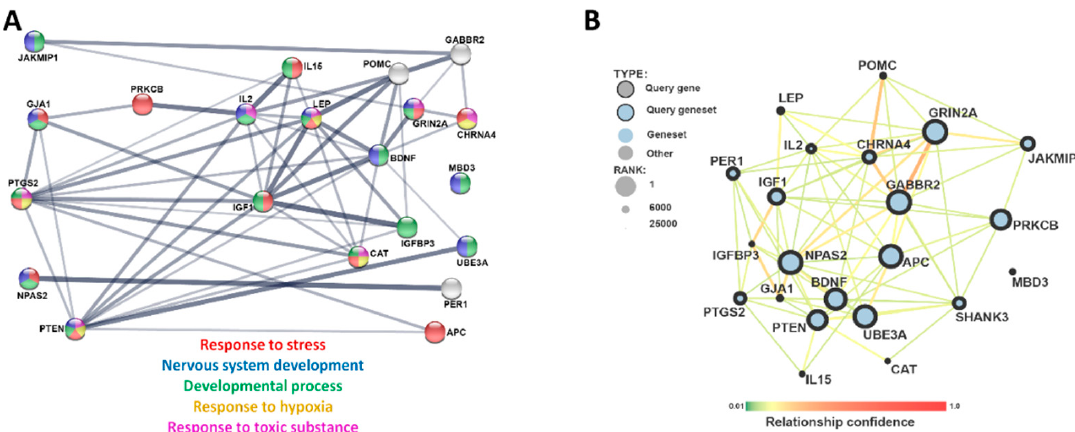
Figure 3. STRING analysis of the genes associated with the enhancers of interest. ( A ) The 4 genes on the far left are the genes with enhancer regions that are more accessible following DPM exposure and the 17 on the right enhancer regions that are less accessible following DPM exposure. The single gene that has both negative and positive enhancer regions, PRKCB , is highlighted in the red box in the middle of the plot. The gene SHANK3 is not included on this chart because it is not in the STRING human protein database. Gene ontology enrichment terms are highlighted by color. There is an enrichment for the following biological processes based on gene ontology: response to stress (FDR 0.00041), nervous system development (FDR 0.00046), developmental process (FDR 0.00046), response to hypoxia (FDR 0.00021), and response to toxic substance (FDR 1.84 × 10 − 5 ). ( B ) Interaction map of the 22 genes with enhancers that are di ff erentially accessible visualized using an interaction network of genome wide ASD genes.